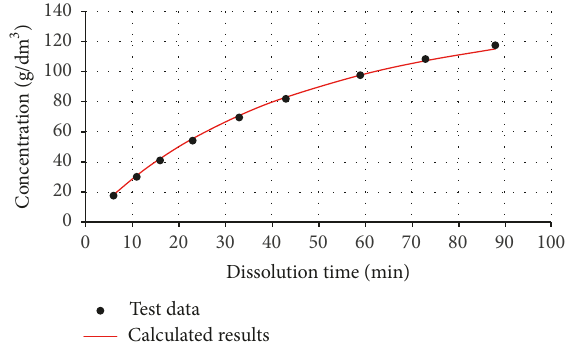
Figure 7: Dissolution parameter ( 𝐷/𝛿 ) of rock salt at different flow rates ( 𝑄